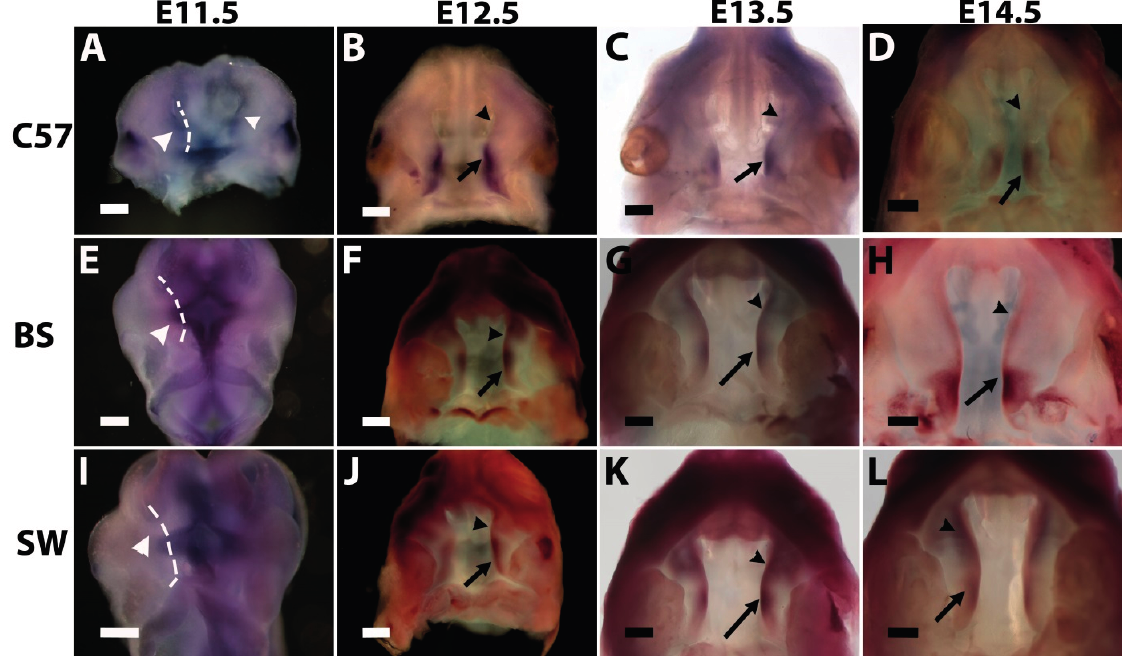
Figure 1. The expression of Meox-2 during mouse secondary palate development on the backgrounds of C57B6 ( A – D ), Black Swiss ( E – H ) and Swiss Webster ( I – L ). Dashed lines in ( E ) and ( I ) indicate the unstained palate outgrowth areas. Arrows and arrowheads indicate to different regions in palate shelves, as illustrated in the Results and Discussion section. Scale bars represent 228 μ m ( B , D , F , J ) and 285 µm ( A , C , E , G – I , K and L ); C57, BS and SW are the abbreviations for C57B6, Black Swiss and Swiss